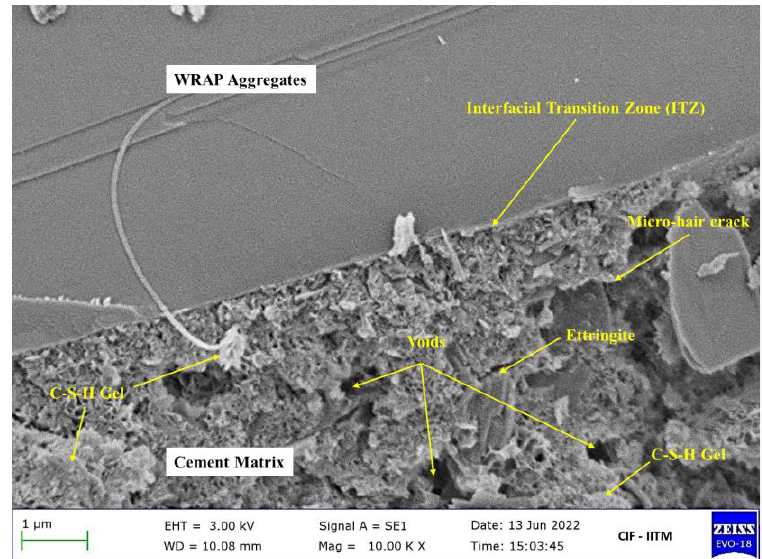
Figure 10. Microstructure of RAP concrete mixes using FE-SEM images.